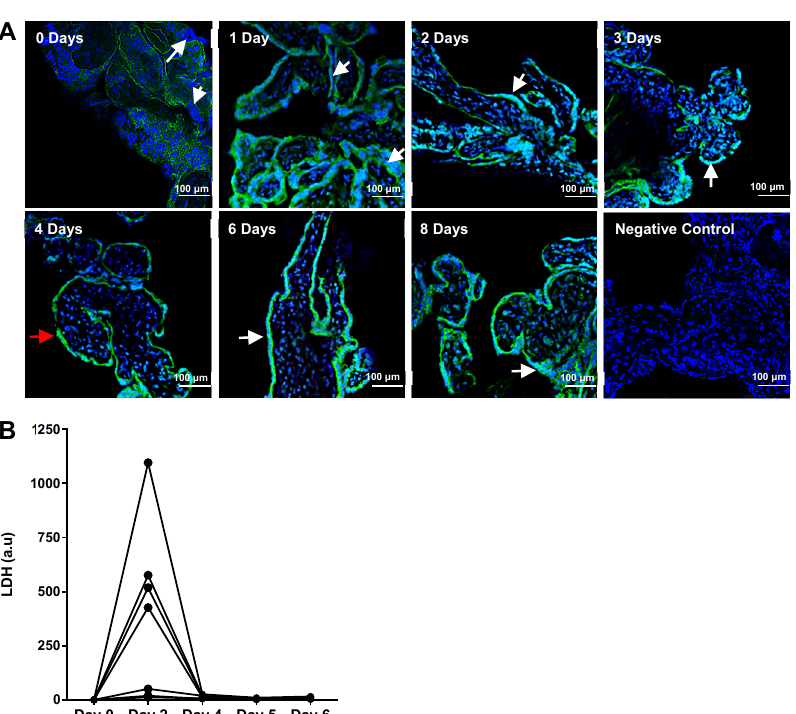
Figure 2. Syncytial shedding in chorionic villous explants was maximal after 4 days of incubation. ( A ): Confocal fluorescence microscopy was used to analyze the shedding of ST and resyncytialization of term chorionic explants after incubation for 0–8 days. DAPI stained nuclei blue and E-cadherin (AF488) stained epithelial cadherin junctions in CT and ST cell membranes green ( n = 5). High E-cadherin expression demarcates the basal membrane of the syncytium. Nuclei present on the apical side of the heavy E-cadherin demarcation are part of the multinucleated ST. High areas of multinucleated syncytium are demarcated with white arrows and low areas of multinucleated syncytium are demarcated with red arrows. For the negative control, AF488 secondary antibodies were used in the absence of primary antibody. ( B ): Lactate Dehydrogenase (LDH) released into supernatants from chorionic explants was measured across various timepoints. Linked data points correspond to individual experiments ( n = 6) and each data point represents the average of duplicate wells. Measurements correspond to LDH release in the last 24 h prior to every displayed time point. Values were plotted as a change from day 0. All values are relative to total protein mass in each culture well.